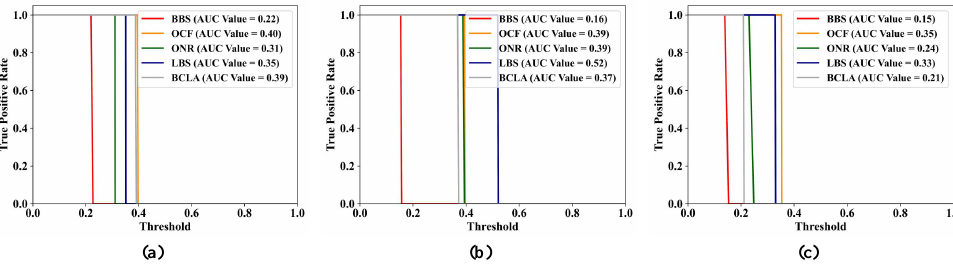
Figure 19. The ROC of ( P F , Threshold ) for the UTD results on the turbid water data set with different band selection methods. The number of selected bands is ( a ) 8, ( b ) 18, ( c )